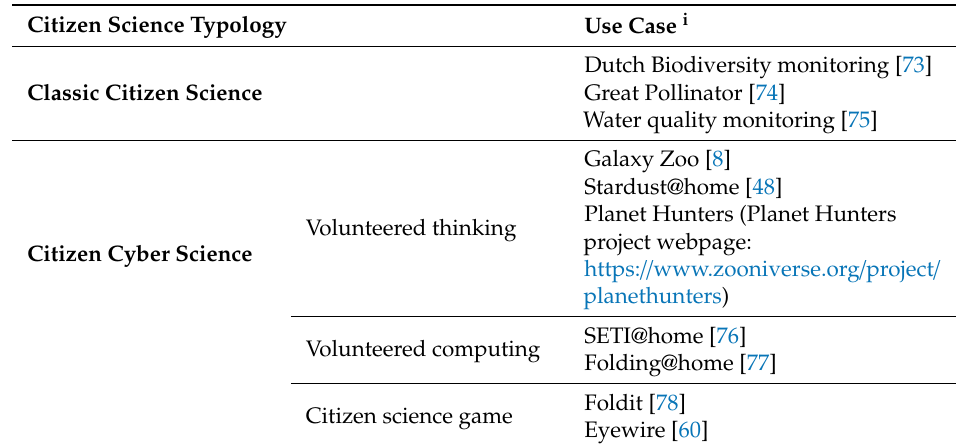
Table 2. Use cases reviewed in this article for each citizen science